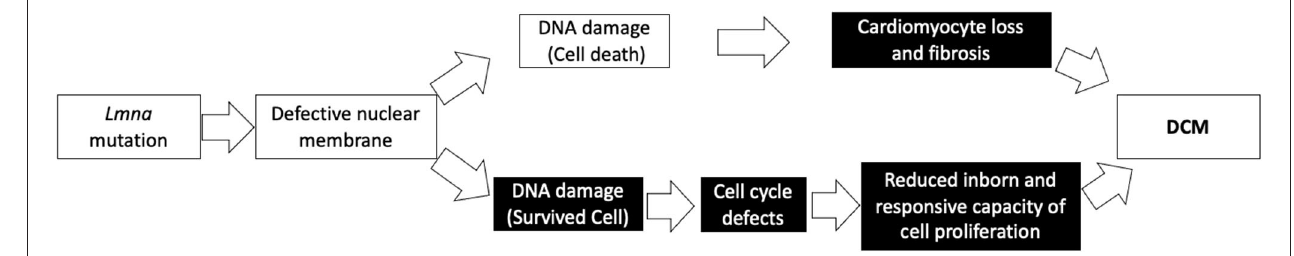
FIGURE 6 | Our model depicting a possible mechanism in the development of DCM with a Lmna mutation. Black boxes denote findings from this